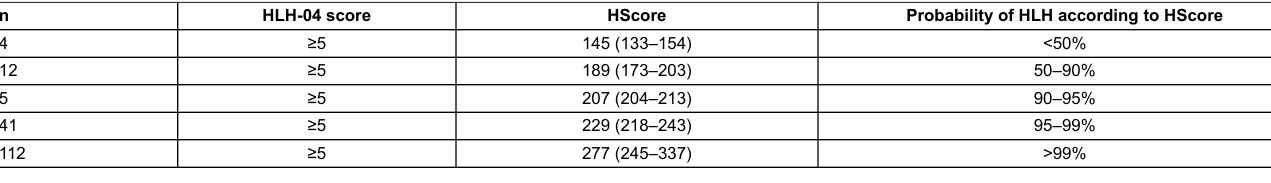
Table 1: HLH diagnostic criteria fulfilled according to HLH-04 and to the Hscore.